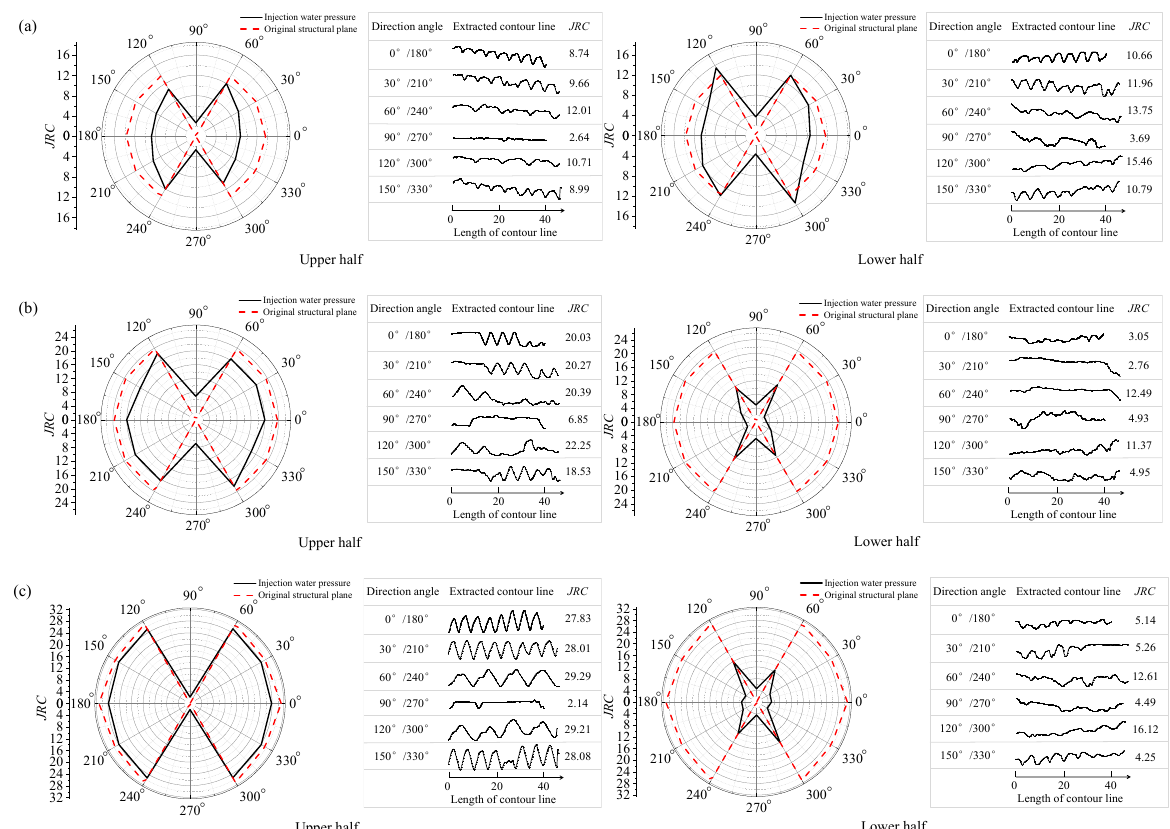
Figure 11. Polar charts of the roughness coefficient, JRC , and the calculated JRC values for contour lines in different directions (shear displacement = 25 mm) for fluctuation angles of ( a ) 15°, ( b ) 30° and ( c ) 45°.